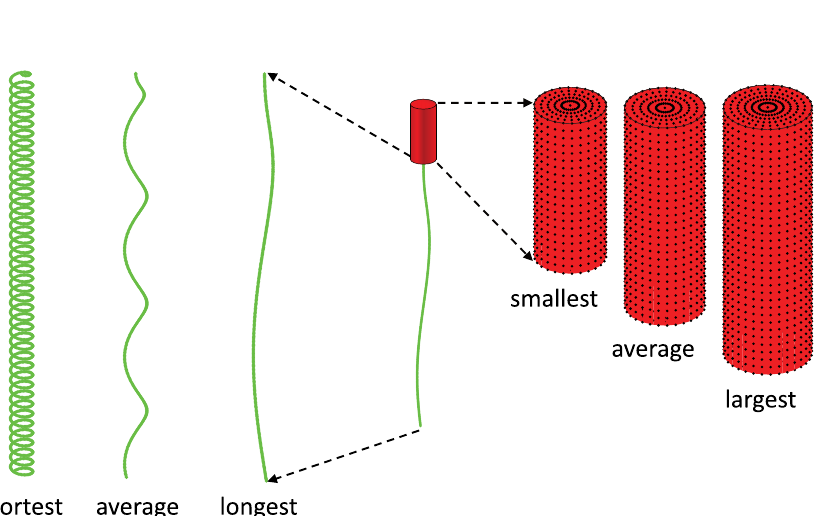
Figure 2. Our model bacterium had a cylindrical cell body and a helical flagellum, and 25 different cell body sizes and eighteen different flagellar wavelengths were used, as described in Table 2. Three cell bodies with the smallest, average, and largest volumes, respectively, are shown on the right, whereas the three flagella with the shortest, average, and longest wavelengths are presented on the left. The middle shows an example of one such model, which has the smallest body and the longest wavelength flagellum.